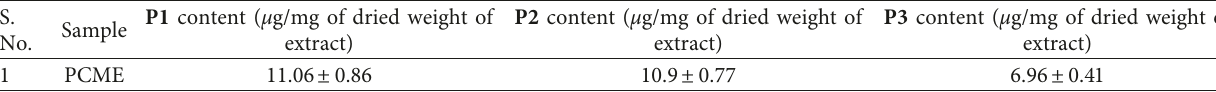
Table 9: HPTLC analysis of P1 , P2 , and P3 in